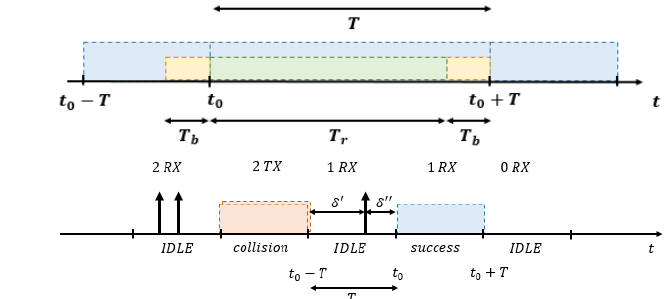
Figure 1. ( a ) Slot width definition in S-ALOHA, ( b ) example of free, collided and successful slot.